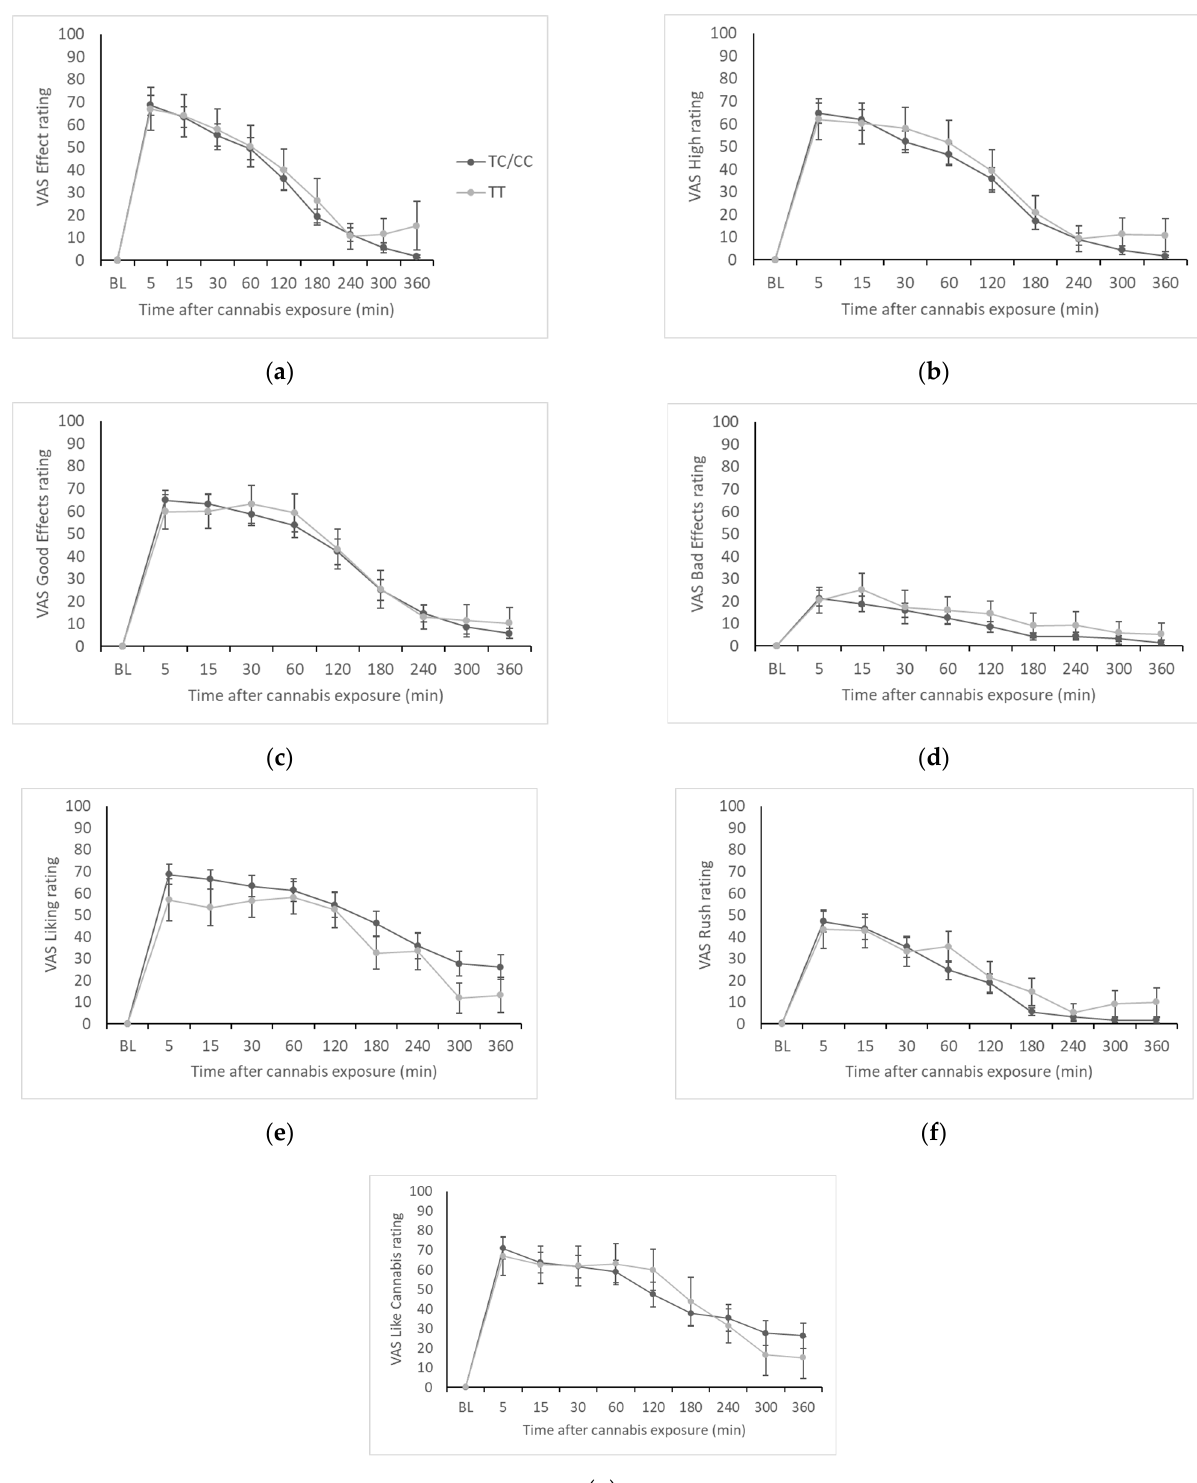
Figure 2. VAS ratings by genotype group. ( a ) VAS Effect; ( b ) VAS High; ( c ) VAS Good Effects; ( d ) VAS Bad Effects; ( e ) VAS Liking; ( f ) VAS Rush; ( g ) VAS Like Cannabis. Table 3. VAS maximum effect and Area-under-the-Curve (AUC).